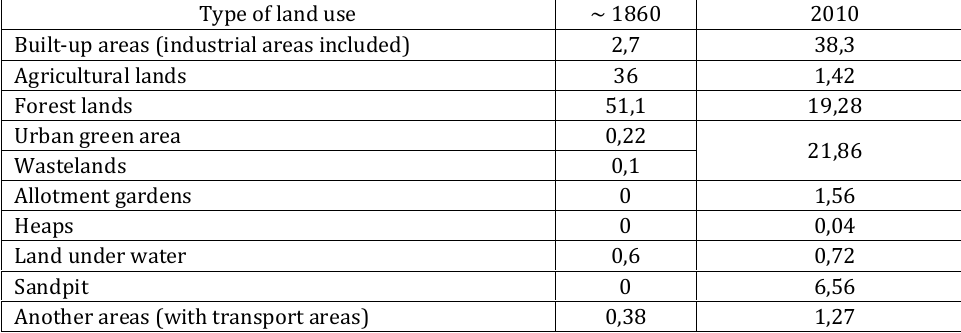
Table 1. Land use in Sosnowiec (in km 2 ) in the mid-nineteenth century (~ 1860) and today (2010) (after Czaja, 1994; Central Statistical Office,